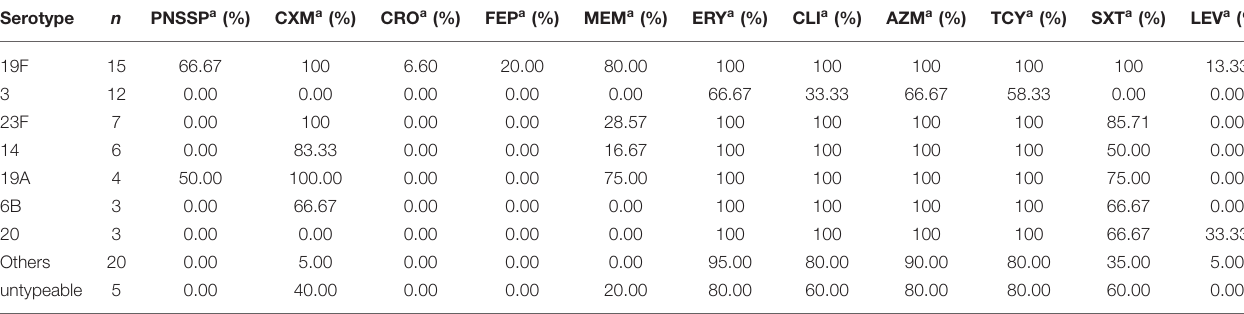
TABLE 4 | Resistance rates of S. pneumoniae among different serotypes in Shanghai.